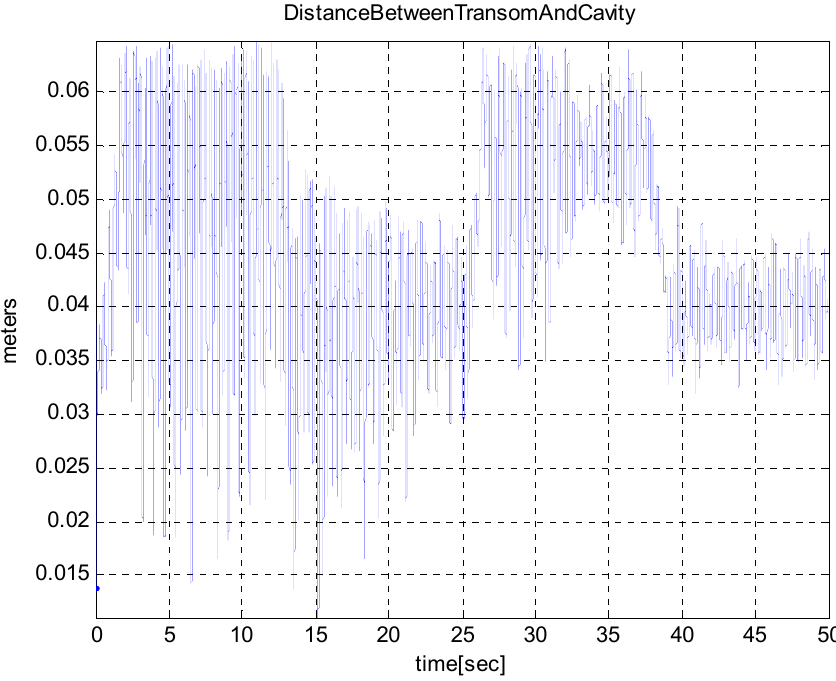
Figure 10. The distance between the transom of the vehicle and the cavity wall (controllers considering noisy environments and fuel consumption).